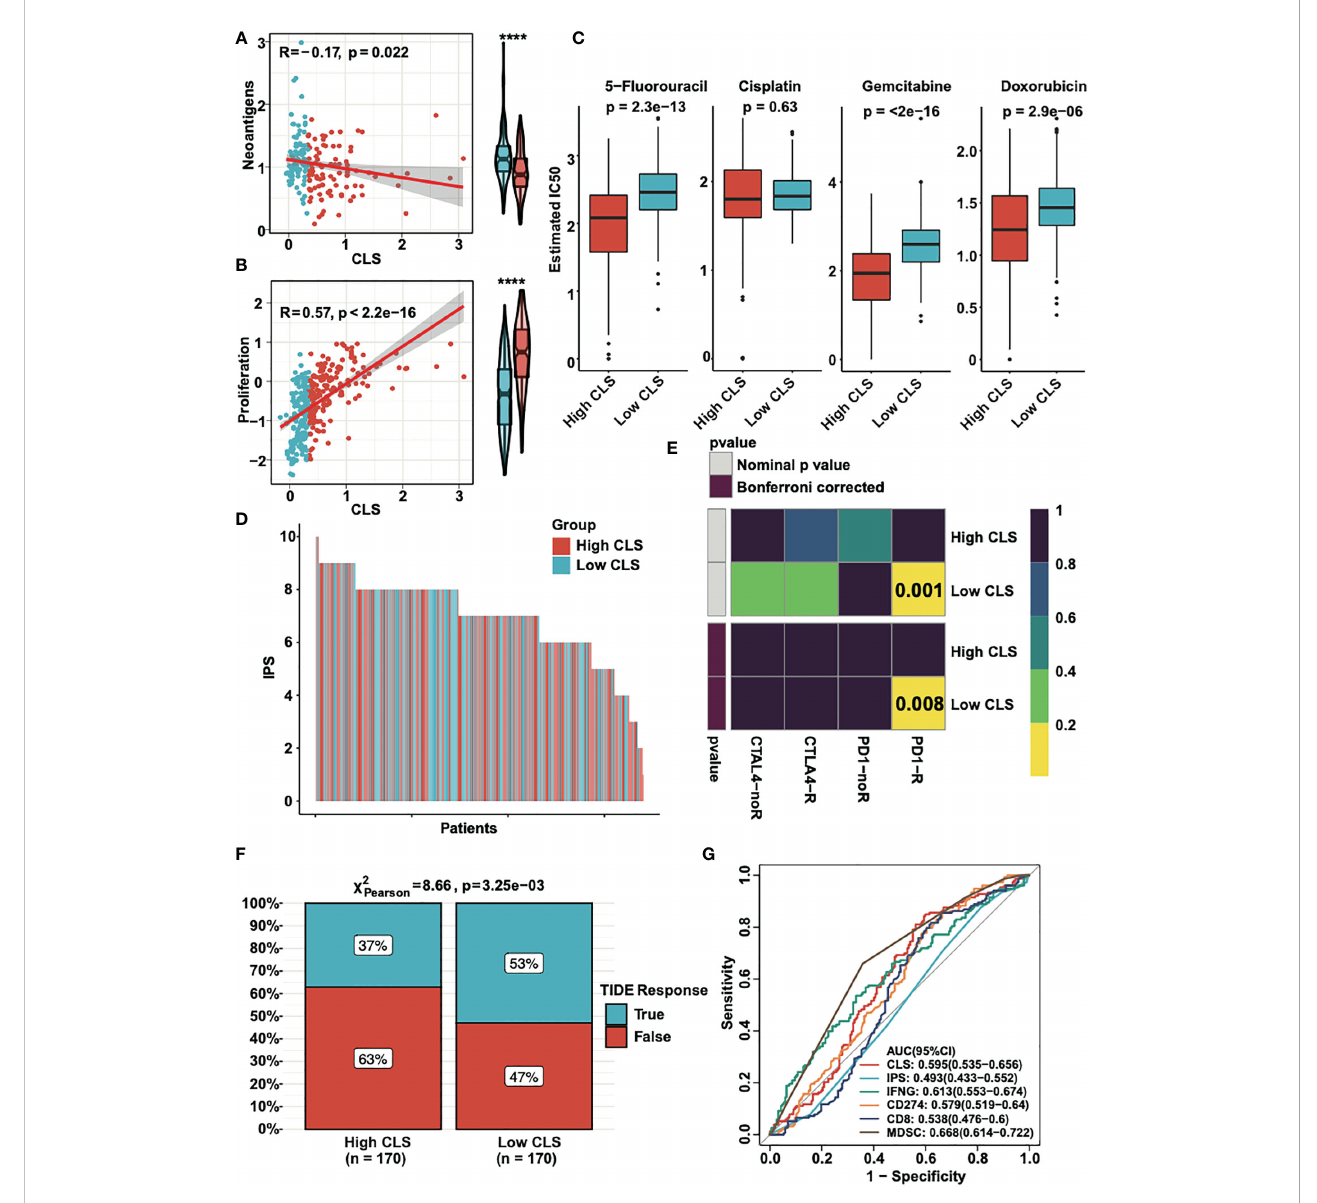
FIGURE 7 The clinical application of CLS model. (A) The expression and the correlation of the neoantigens in high and low CLS samples. (B) The expression and correlation of the proliferation score in high and low CLS samples. (C) The estimated IC50 of 5- fl uorouracil, cisplatin, gemcitabine and doxorubicin in high and low CLS samples. (D) The IPS of each patients with high or low CLS. (E) TIDE analysis of the PD1 and CTLA4 response in patients with high and low CLS. (F) The proportion of the TIDE response in high and low CLS patients. (G) The AUC analysis of the CLS and biomarkers. IPS,